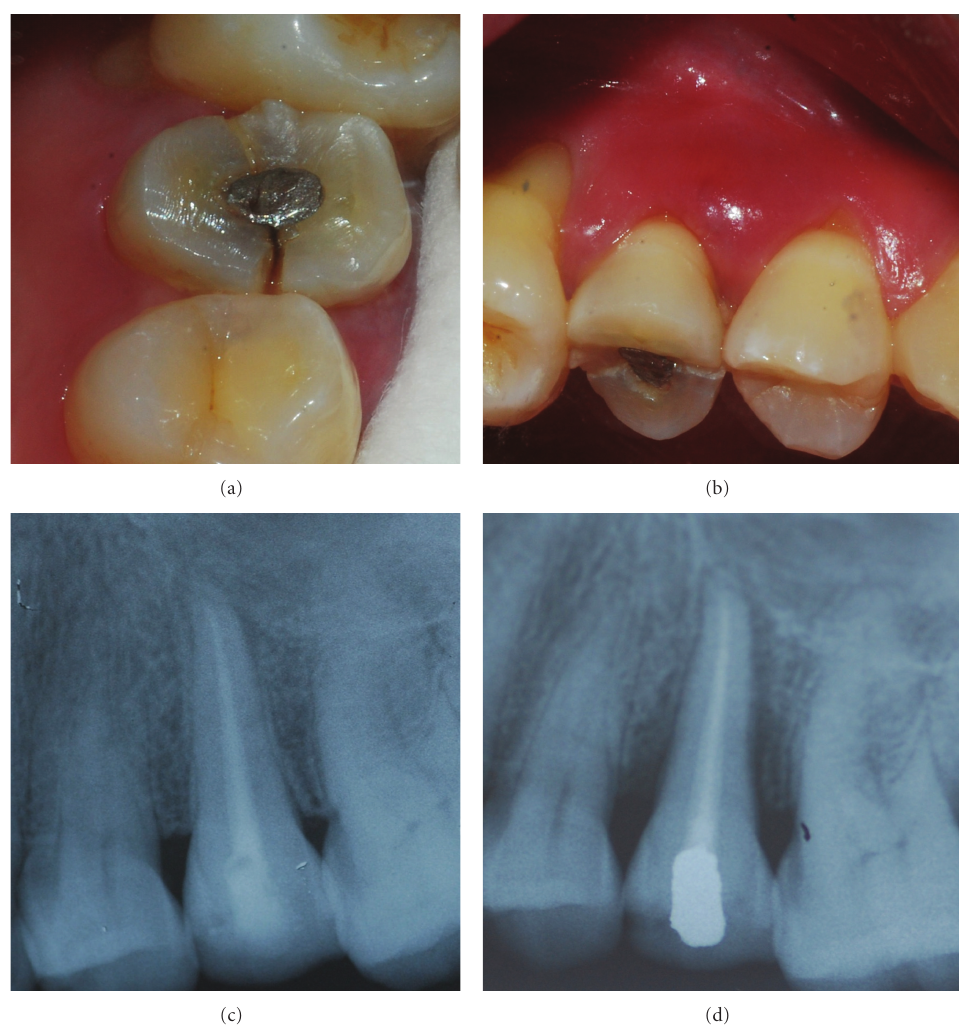
Figure 1: (a) Fracture extending mesiodistally on centre of occlusal surface and then onto proximal surface of 25. (b) Di ff use swelling of the buccal gingiva. (c) Post obturation intraoral periapical radiograph of 25. (d) Intraoral periapical radiograph taken after 15 months shows severe angular bone loss interproximally associated with propagation of fracture